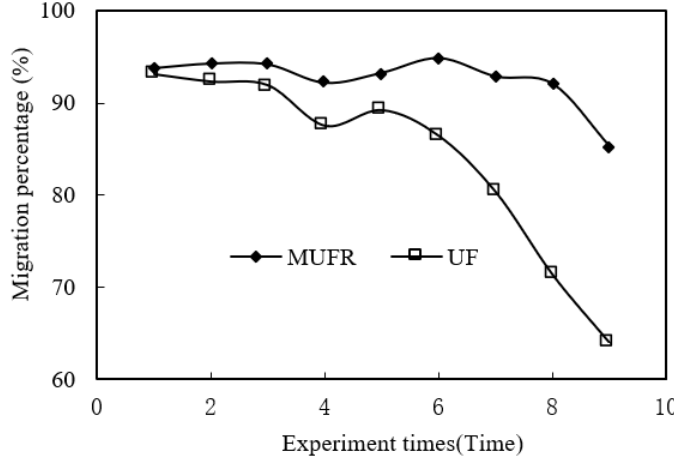
Figure 14. Reuse effect of PAN microtubules.